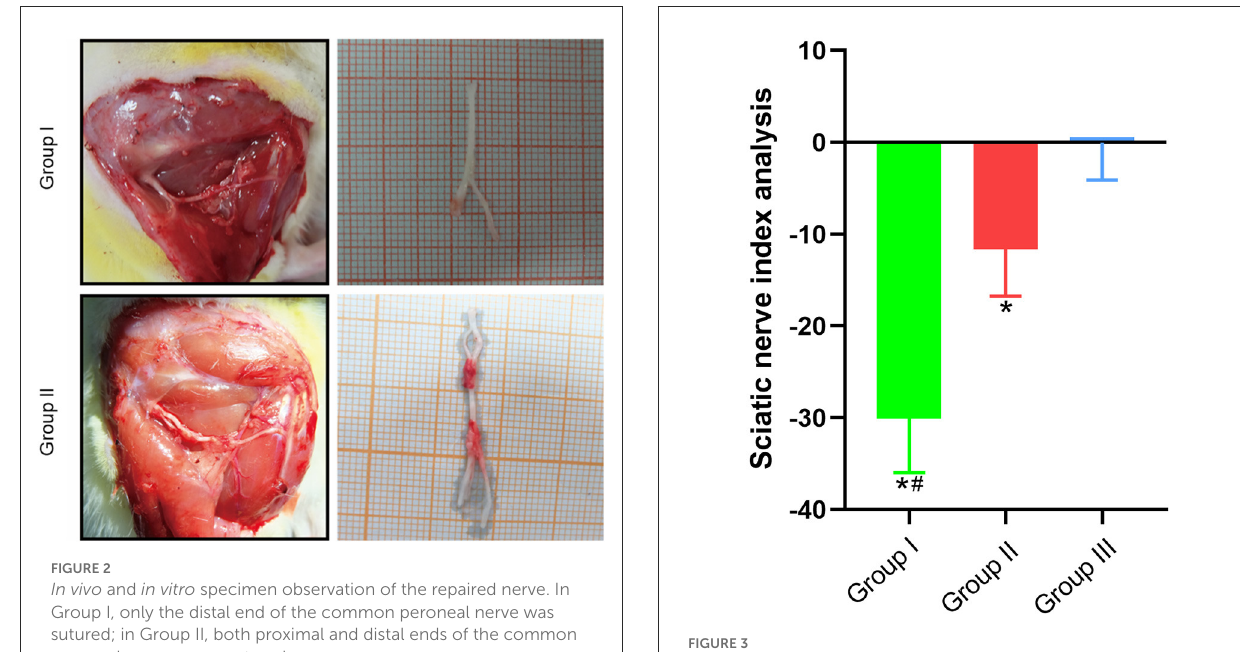
FIGURE3 Sciatic functional index. In Group I, only the distal end of the common peroneal nerve was fostered; in Group II, both proximal and distal ends of the common peroneal nerve were fostered; Group III was sham operated normal group. Data are expressed as mean ± SD ( n = 6 in Group I, 6 in Group II and 6 in Group III). * P < 0.05, vs. Group III; # P < 0.05, vs. Group